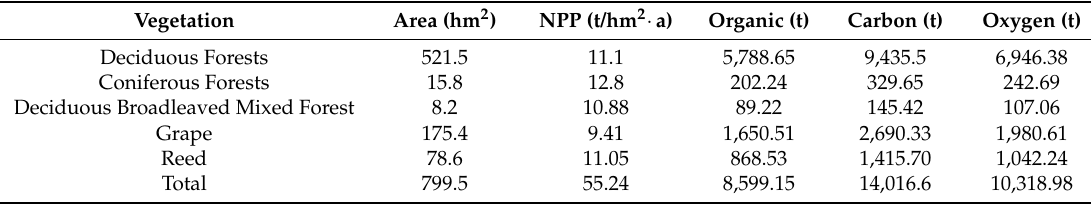
Table 6. The plant carbon fixation and oxygen release in Lakeside Wetland Park.